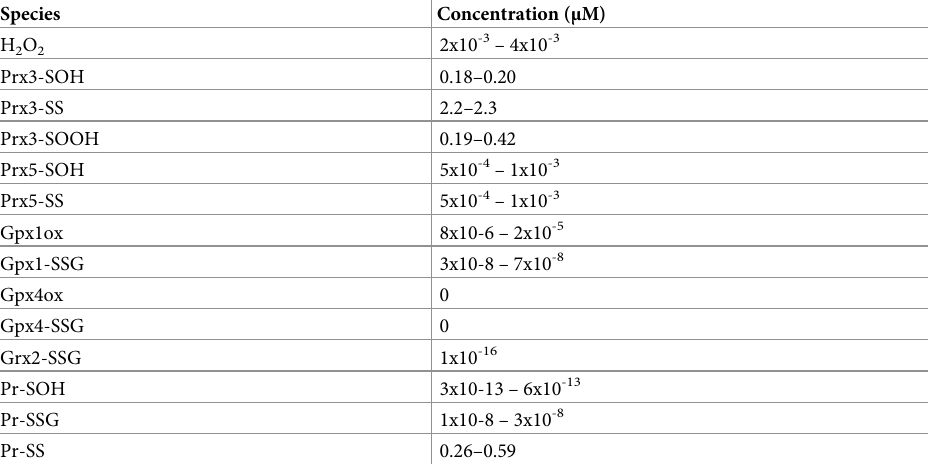
Table 3. Derived initial species